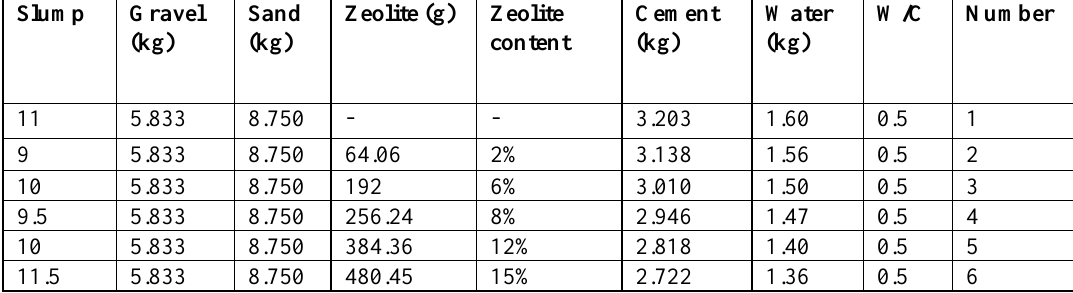
Component values of 380 kg / m 3 concrete mixes studied.